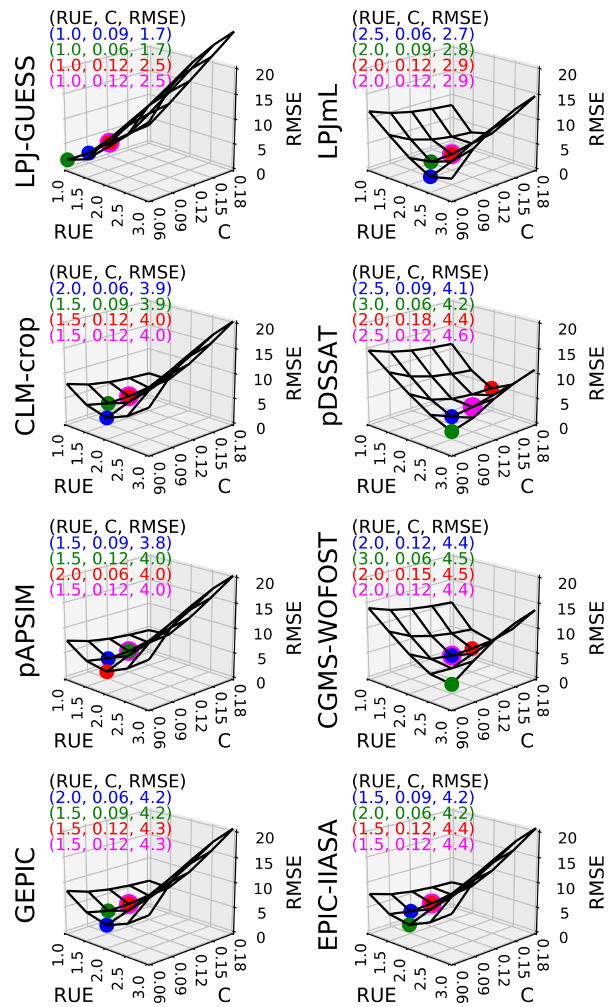
Figure 3. Sensitivity of global RMSE (biom SMM , biom GGCM ) (tDMha − 1 ) to C ( − ) and RUE (gDMMJ − 1 ) for each GGCM. For each GGCM, the shape of RMSE is derived from 25 SMM simu- lations (five values of C combined with five values of RUE). Other SMM parameters are equal to their respective initial estimate. For each GGCM, three ( C , RUE) pairs that minimize the most RMSE among the 25 pairs tested are plotted in blue, green, and red. A fourth ( C , RUE) pair minimizing the RMSE but with C equal to its initial estimate is shown in magenta. The values of the four ( C , RUE) pairs and the corresponding RMSE are given in top left of each